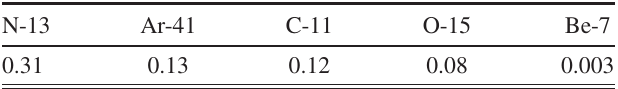
TABLE VII. Annual effective dose to the reference population: contributions from the main radionuclides in μ